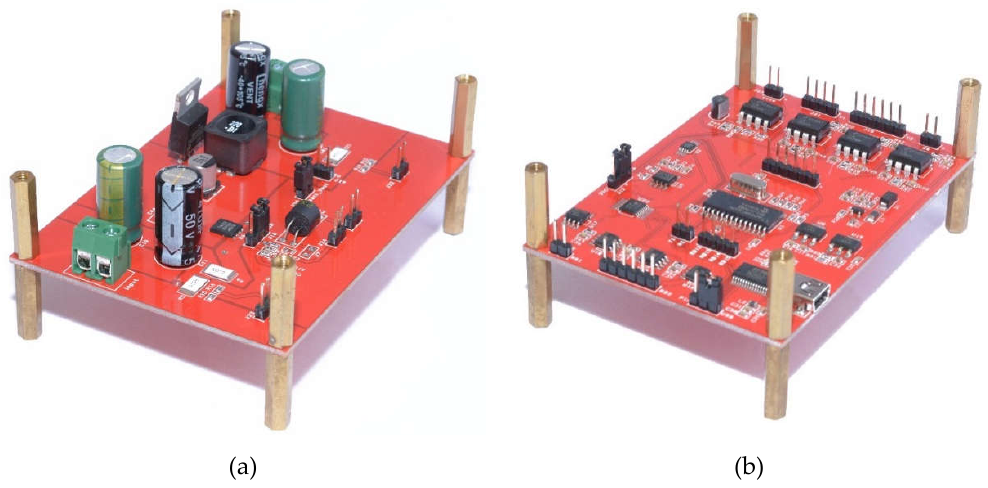
Figure 19. Auto-ranging power converter: (a) Zeta buck-boost converter, (b) control board.